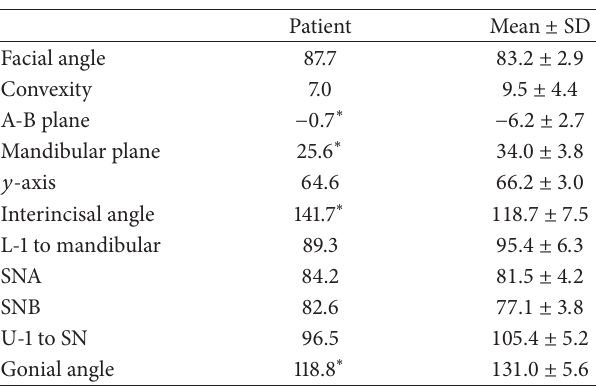
Table 1: Cephalometric